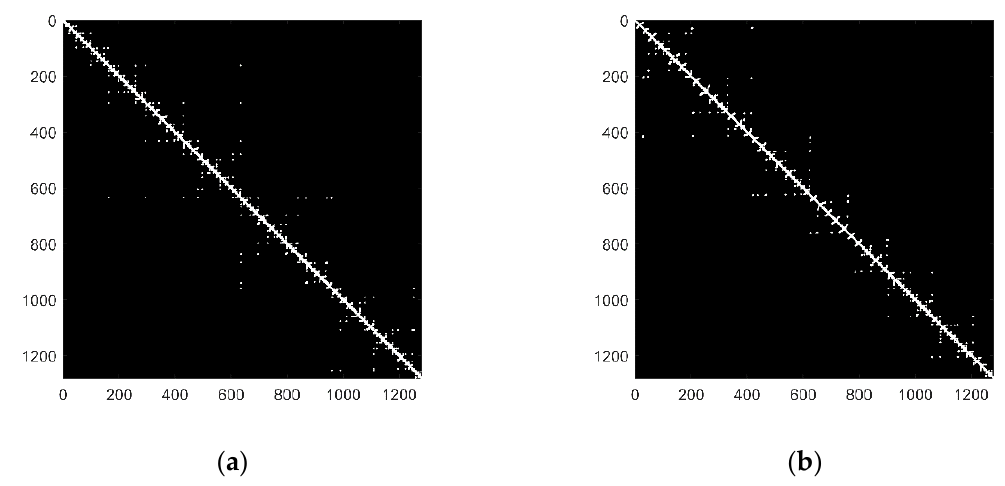
Figure 6. The adjacency matrix of networks based on HVG. ( a ) EEG series with low valence; ( b ) EEG series with high valence.